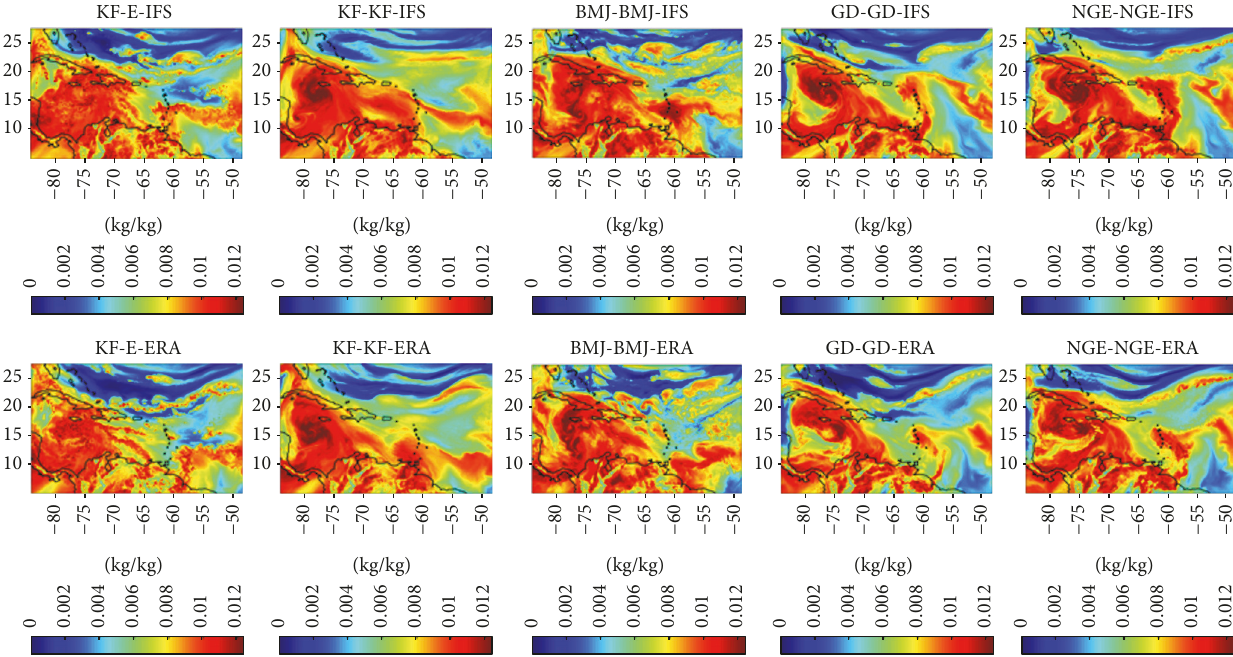
Figure 4: Water vapor horizontal cross section at 𝑧 = 2500 m for the different WRF experiments at 00UTC on 4 November 2010.